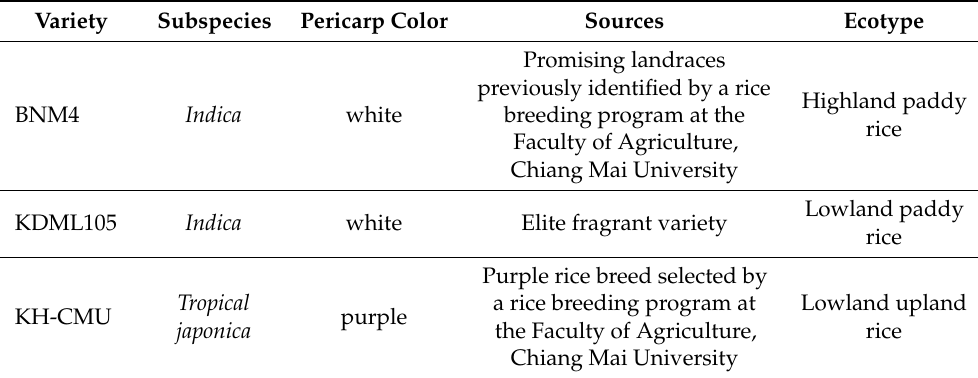
Table 1. Description of Thai fragrant rice